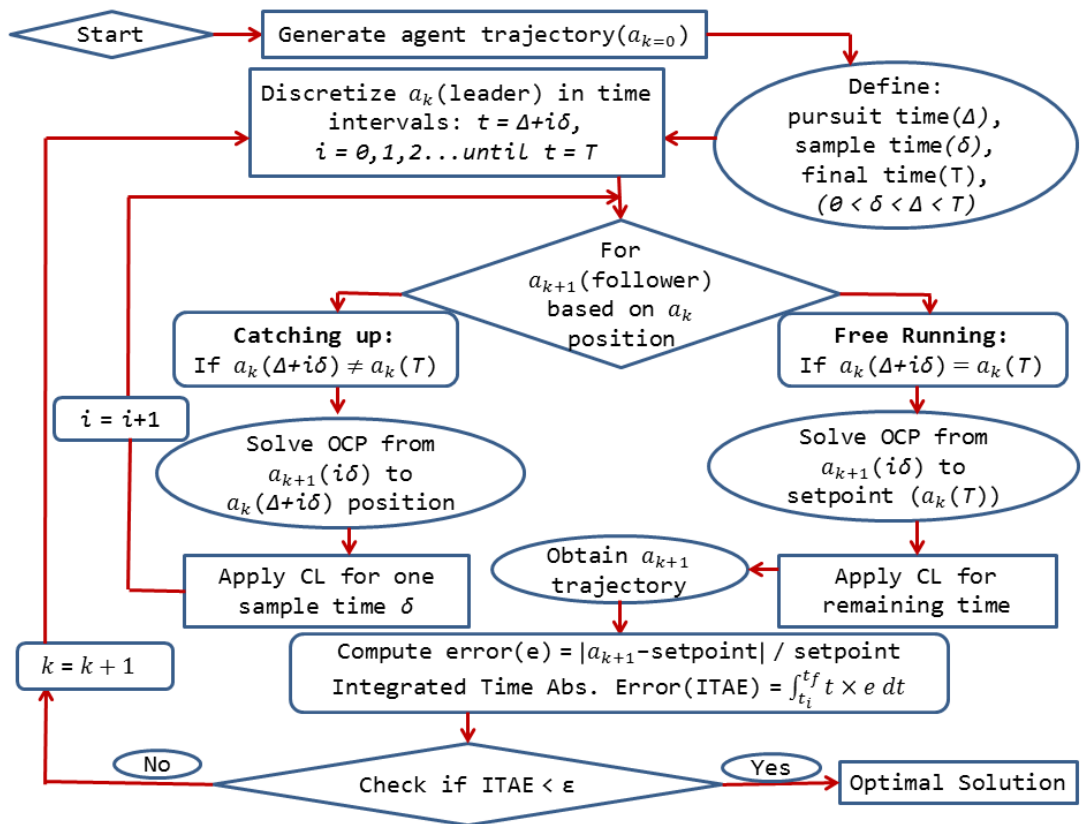
Figure 3. General structure of the algorithm for the advanced control approach [27]. CL: control law; OCP: optimal control problem.